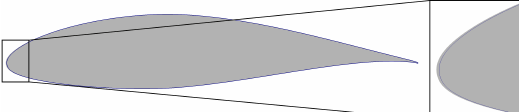
Figure 8. Sketch and close-up view of leading edge model with protection as it is used in the two-dimensional CFD simulations (model with protection in grey and original NACA 64-618 in blue).